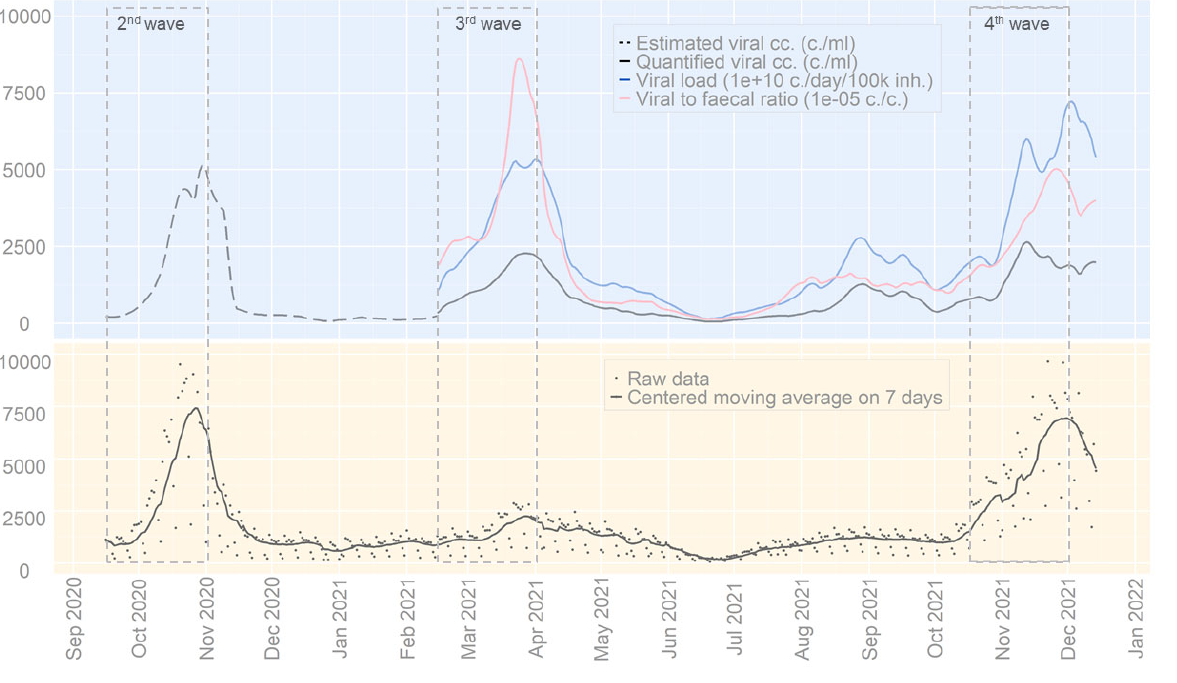
Figure 1. SARS ‐ CoV ‐ 2 concentrations in wastewater and COVID ‐ 19 cases aggregated for all areas covered by the Belgian wastewater surveillance over time. The estimated and quantified viral concentration, the viral load per capita, and the viral to faecal ratio are centred moving average on 14 days. The raw data and centred moving average on 7 days of the daily new cases are presented in the lower graph.